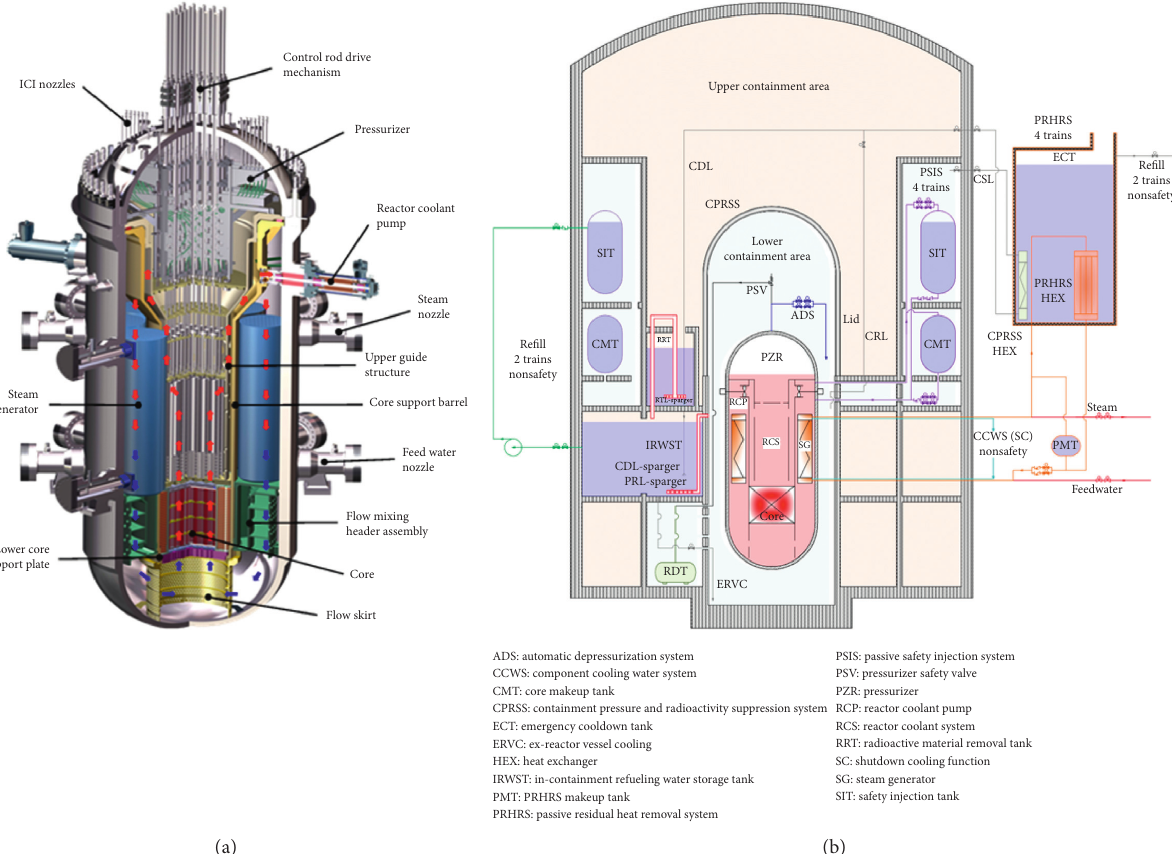
Figure 1: Schematics of the SMART: (a) reactor vessel and (b)